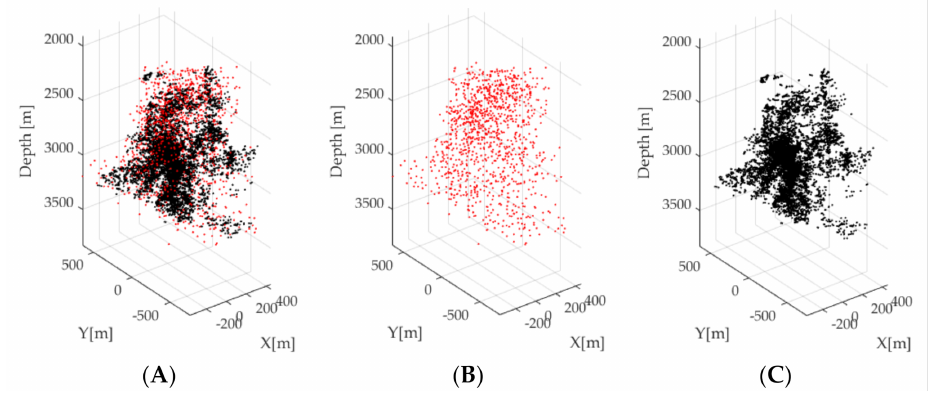
Figure 6. Results of applying the collapsing method on the microseismic cloud. ( A ) All hypocenters of events after the collapsing procedure. The black dots represent events that moved during the collapsing algorithm, while the red dots denote events that did not change their positions. ( B ) Events that did not change their location during the relocation. ( C ) Events that changed their location during the collapsing procedure.